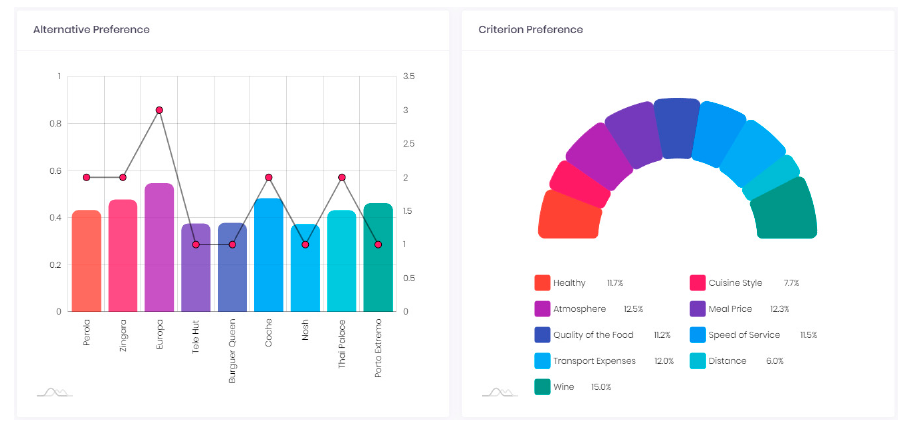
Figure 3. Graphs/elements of the “General Information” screen. Figure 3. Graphs / elements of the “General Information” screen.